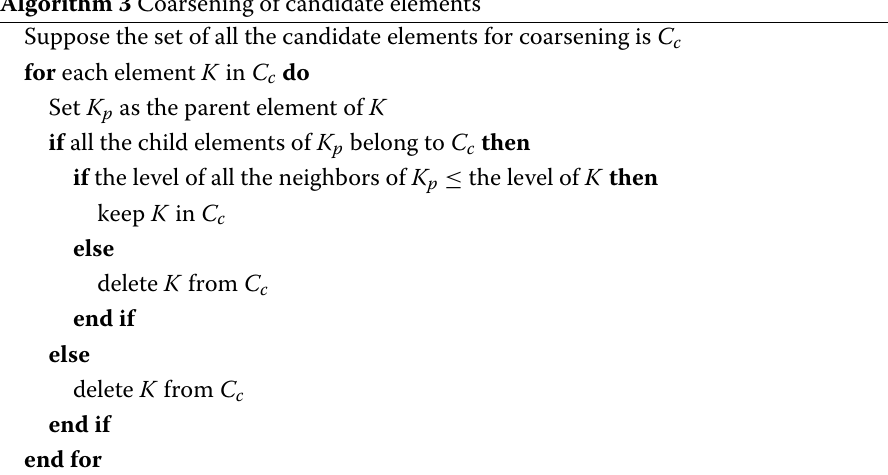
Algorithm 3 Coarsening of candidate